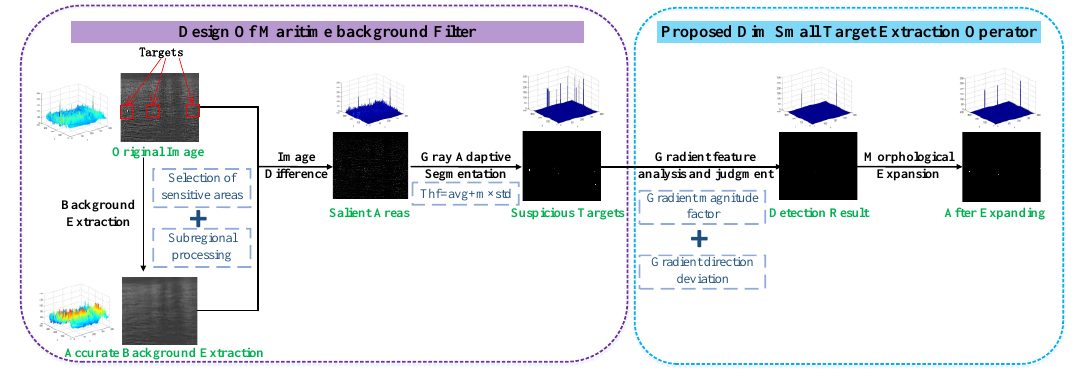
Figure 7. Flow chart of the proposed method.